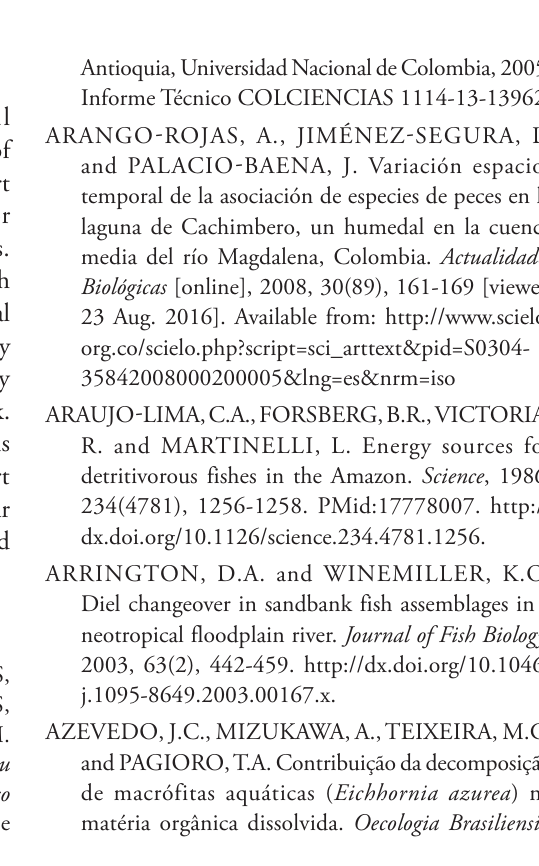
Figure 2. (A) Graphical representation of Canonical Redundancy Analysis based on the abundance of 44 fish species, environmental variables (Temp = water temperature; Cond = electrical conductivity; DO = dissolved oxygen; pH), and limnimetric moments (geometric figures) during the period January 2008 to June 2009; (B) Graphical representation of Canonical redundancy analysis based on the abundance fish assemblage of 44 fish species, environmental variables (Temp = water temperature; Cond = electrical conductivity; DO = dissolved oxygen; pH), and sampling sectors (geometric figures) during the period-January 2008 to June